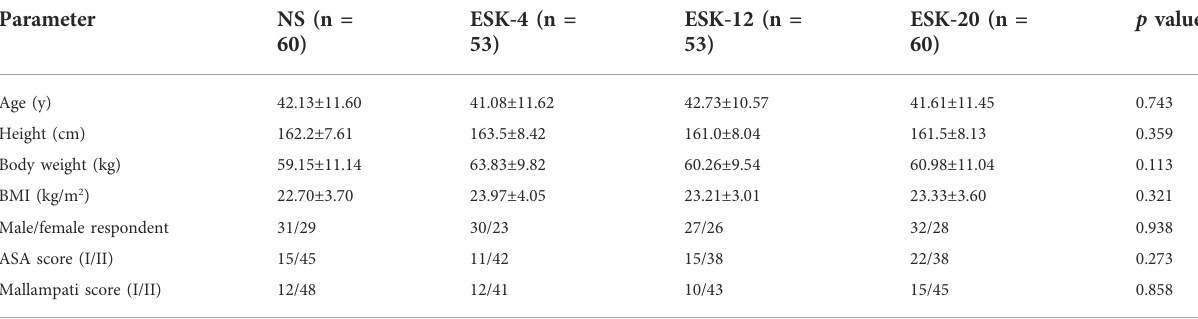
TABLE 1 Patient demographic